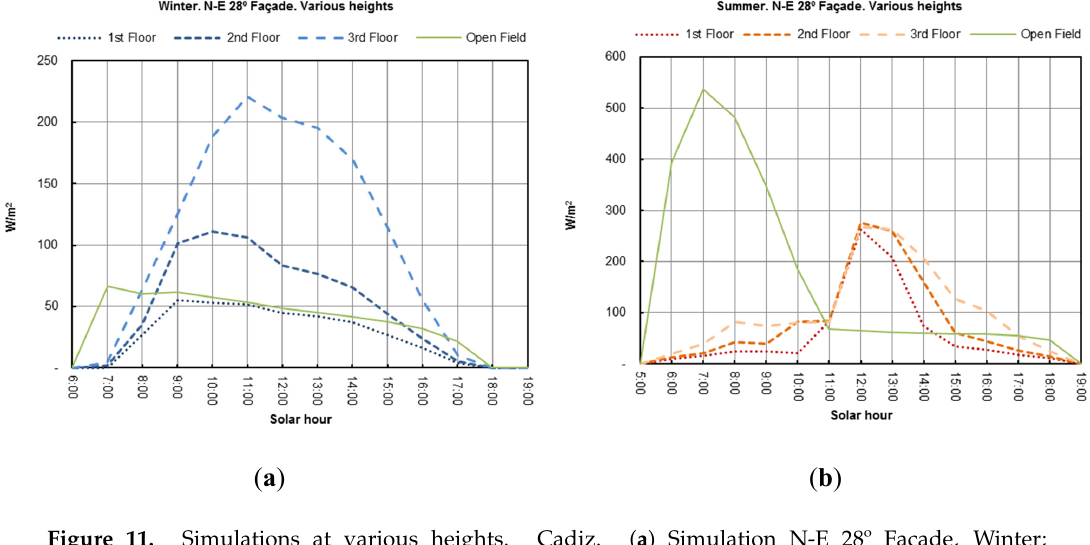
Figure 11. Simulations at various heights. Cadiz. ( a ) Simulation N-E 28º Façade, Winter; ( b ) Simulation N-E 28º Façade, Summer.